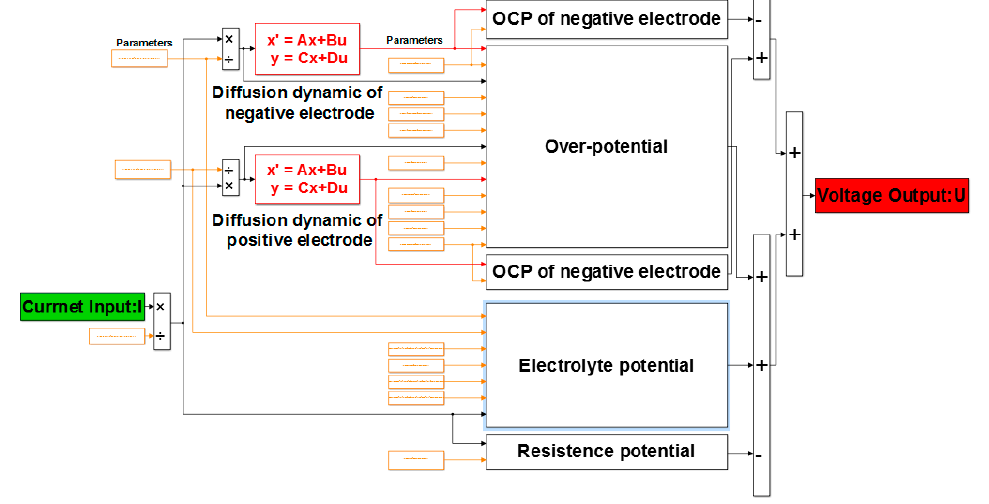
Figure 6. Average electrode model of lithium ion battery. OCP: open circuit potential.